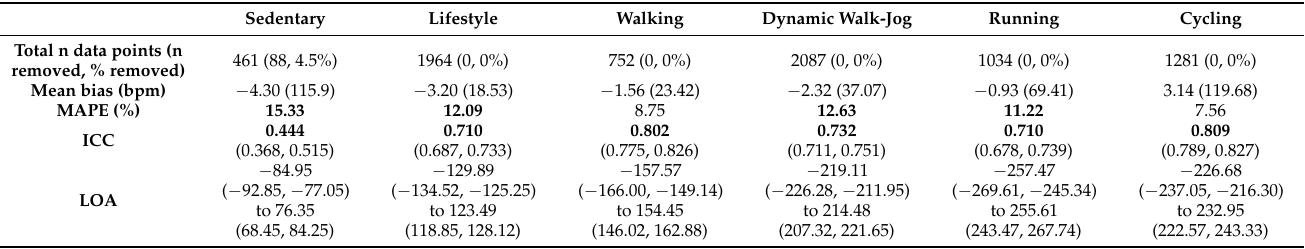
Table 2. Results of all tests for the Garmin 735 XT watch. Bold values indicate MAPE > 10% and ICC < 0.90.